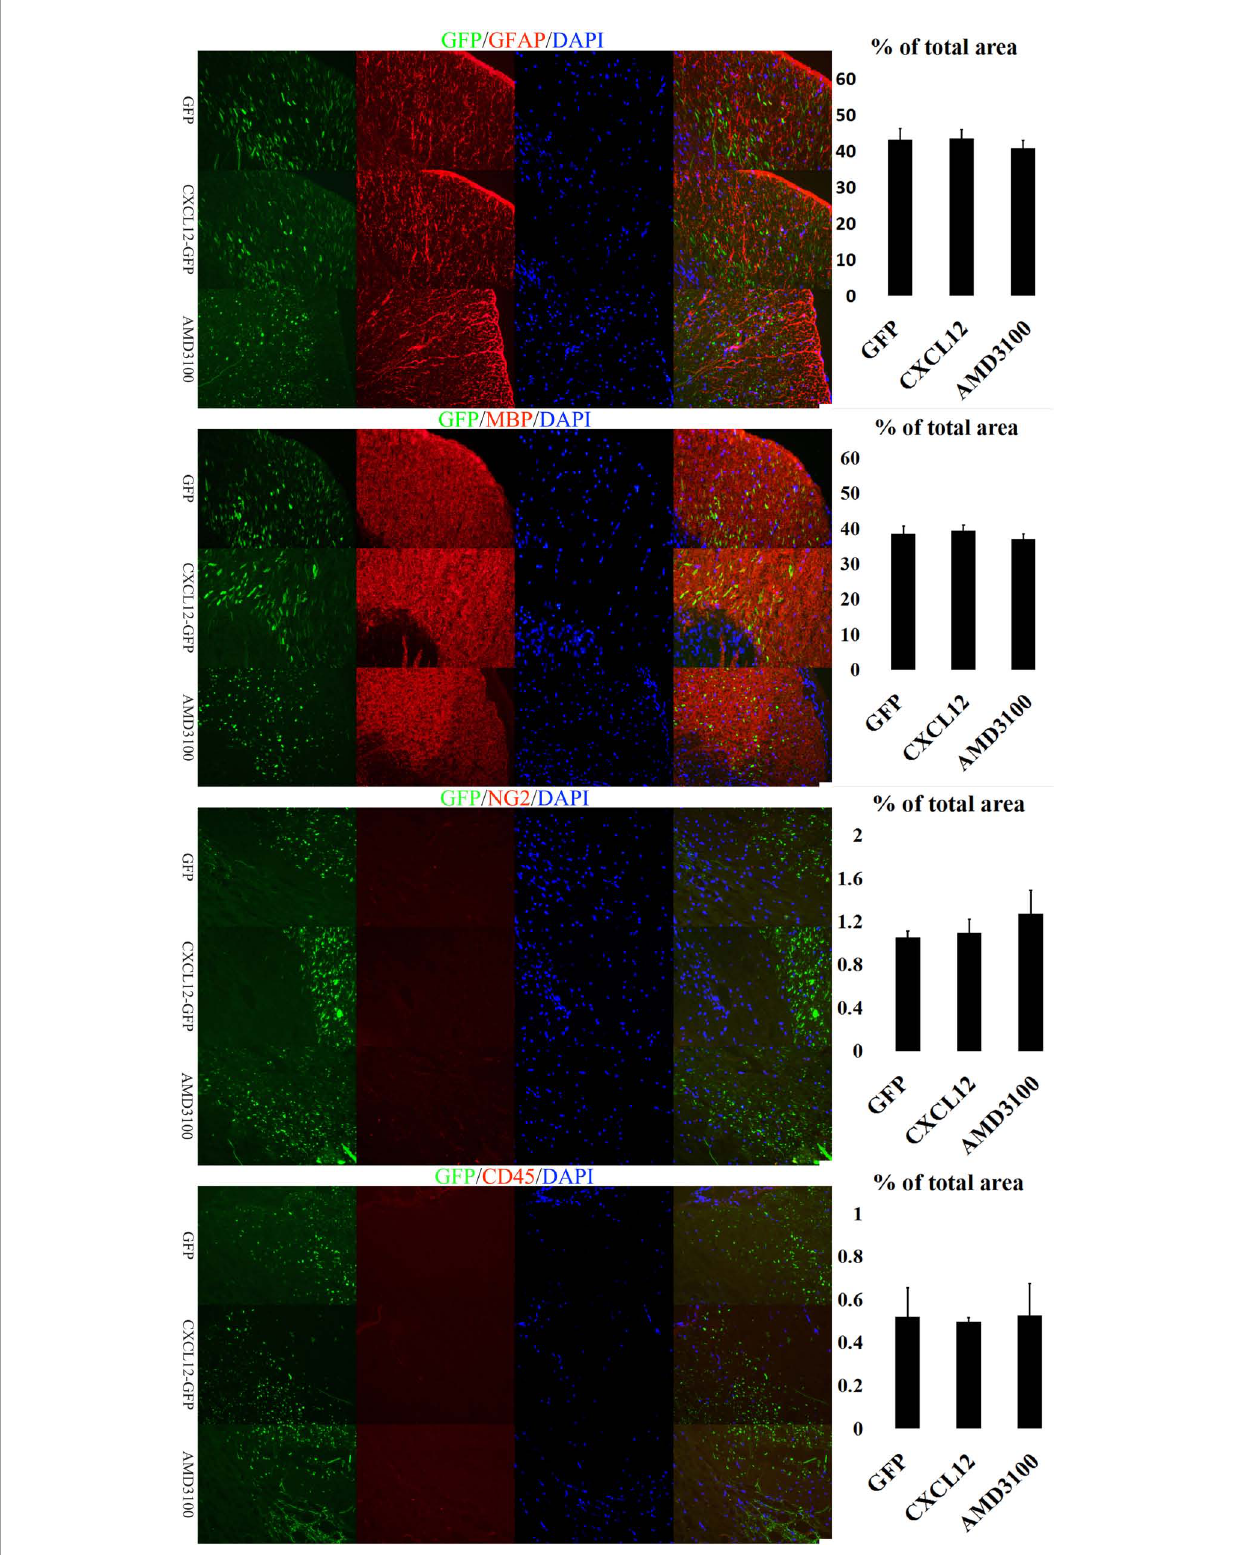
FIGURE3 Upregulation of CXCL12 did not induced peripheral immune cell infiltration in the spinal cord at the initial stage. At the initiation stage of experimental autoimmune encephalomyelitis (EAE), the expression of glial fibrillary acidic protein (GFAP) and myelin basic protein (MBP) was similar in all three groups, indicating that the myelin sheath was intact. During this period, the OPC (NG2 +) and leukocyte (CD45 +) signals in the spinal cord were low. The bar charts show fluorescence intensity. Data presented as the mean ± SEM. “*” represents value of P < 0.05, “**” represents value of P < 0.01, “***” represents value of P < 0.001 by 2-tailed Student’s t -test or 1-way ANOVA, n = 4 rats. The bar in the lower right represents 50 µ